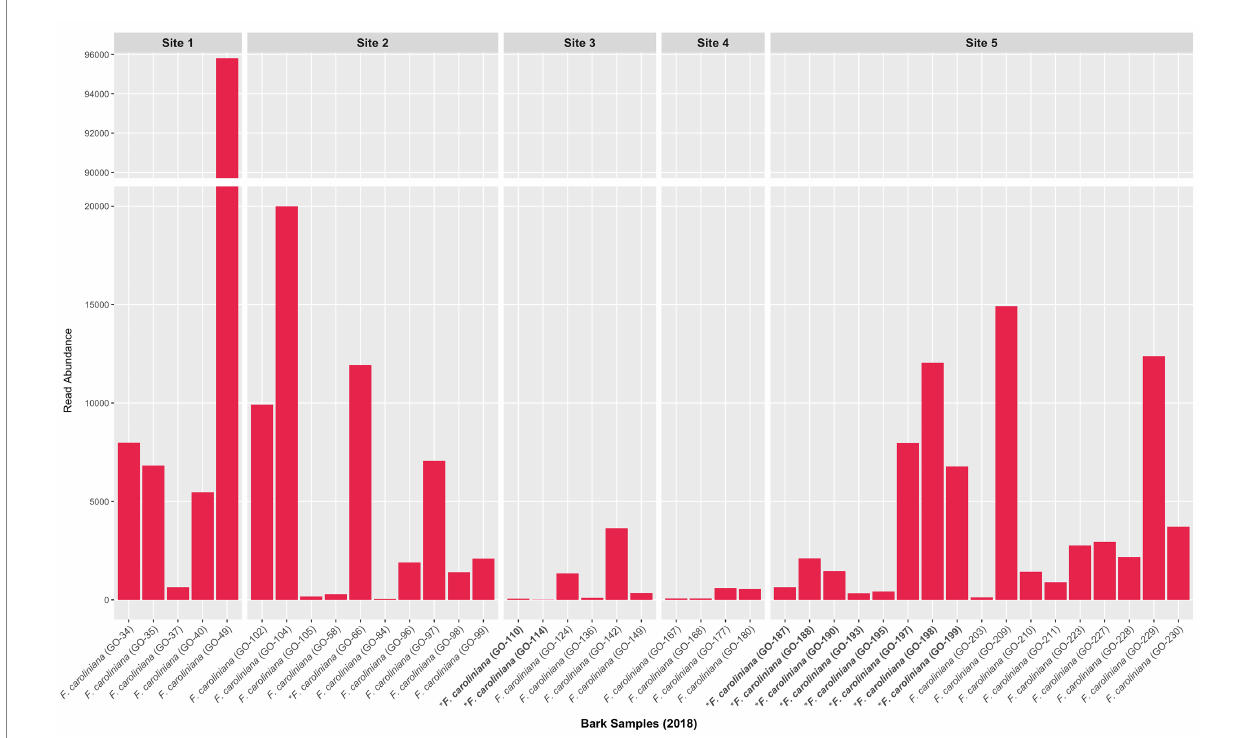
FIGURE 4 Read abundance of Ceratobasidium clade 2 obtained from bark collected in 2018 from trees with and without naturally occurring D. lindenii . Bar graph is condensed to better visualize the sample with the highest read abundance. Trees without naturally occurring D. lindenii are represented in bold and have an asterisk. All bark samples shown in graph are from F. caroliniana obtained at various positions on the trunk except the base (see Supplementary Table S1 for bark sample